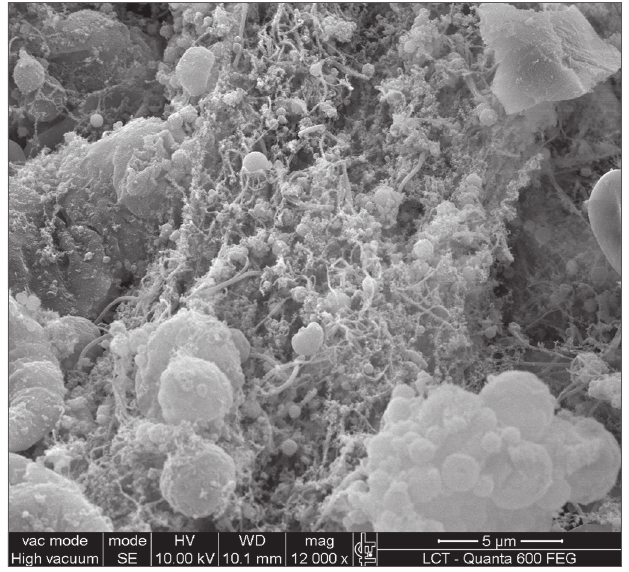
Figura 1b. Biofilme bacteriano